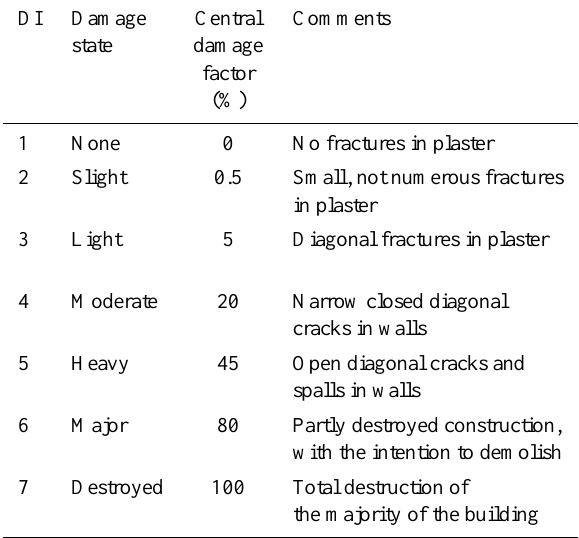
Table 1. The seven-grade scale of damages (based on Whitman,